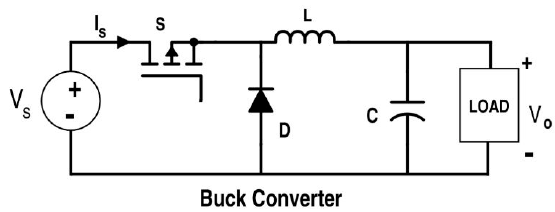
Figure 6. Circuit Model of a DC-DC Buck Converter.